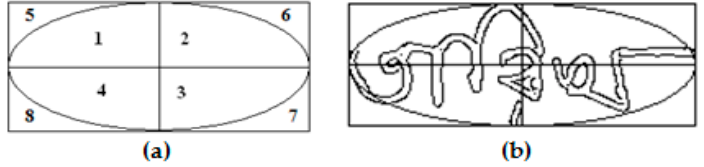
Figure 2. Illustration of fitting ( a ) an imaginary ellipse inside the minimum boundary box which divides a Bangla handwritten word image in 8 regions as shown in ( b ).